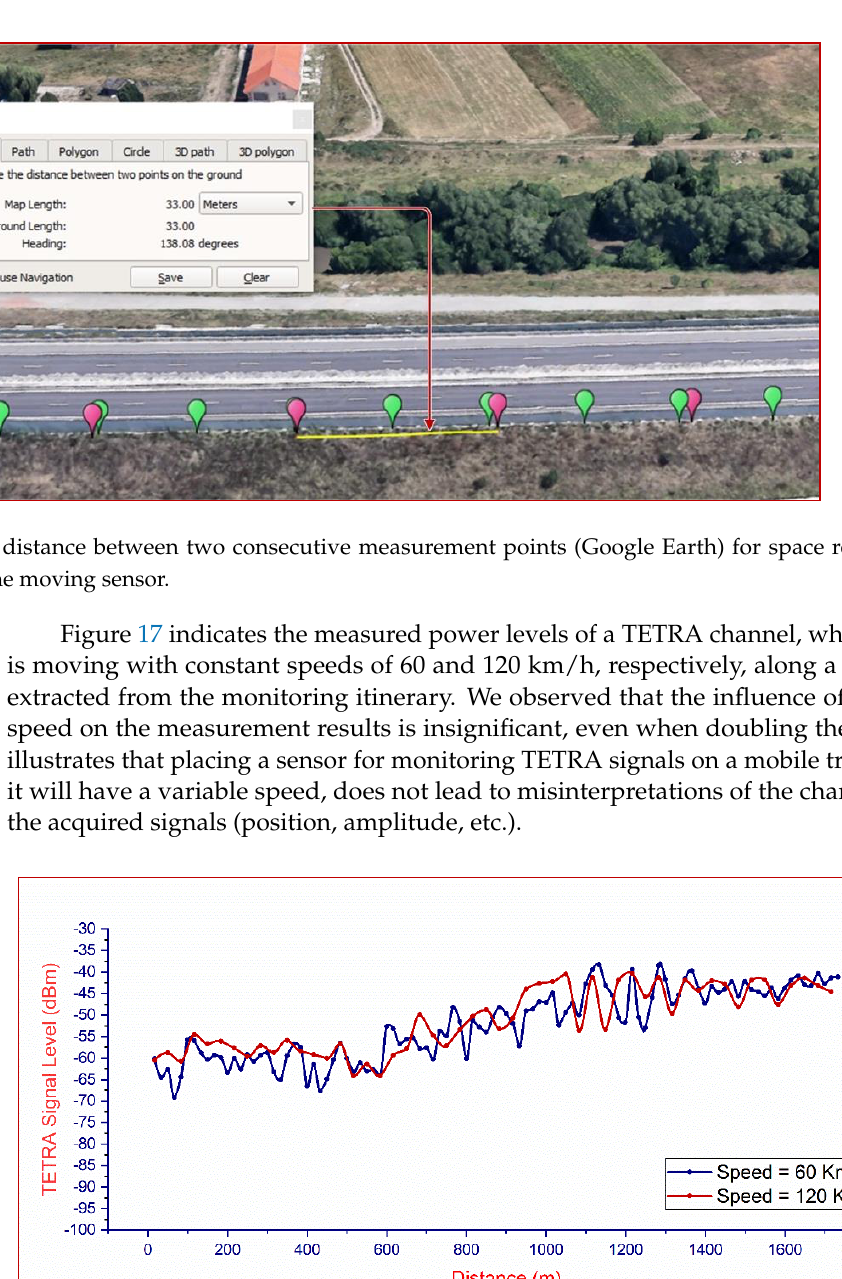
Figure 15. Representation of the measured TETRA channel powers (channel no. 14 and no. 131) when the receiving sensor was moving constantly on a route at different speeds: ( a ) channel 14, speed — 60 Km/h; ( b ) channel 131, speed — 60 Km/h; ( c ) channel 14, speed — 90 Km/h; ( d ) channel 131, speed — 90 Km/h; ( e ) channel 14, speed — 120 Km/h; ( f ) channel 131, speed — 120 Km/h.